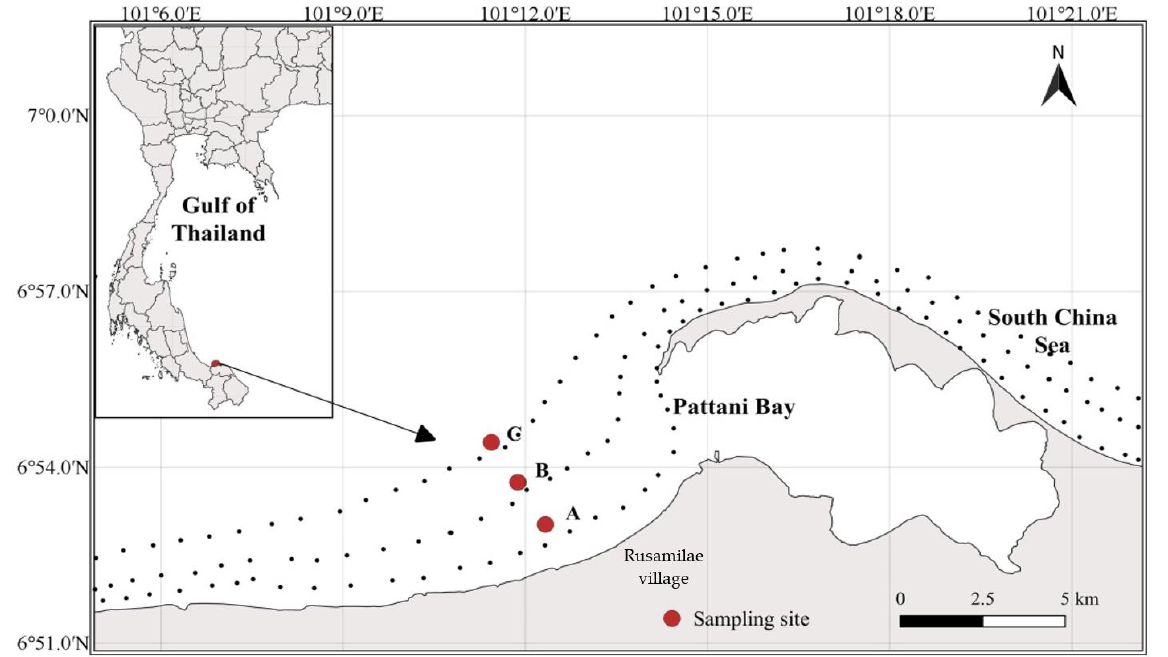
Figure 1. Fish sampling sites off the mouth of Pattani Bay in the lower Gulf of Thailand. The red circles represent the fish sampling sites between the water depth contours of 2, 4, and 6 m.